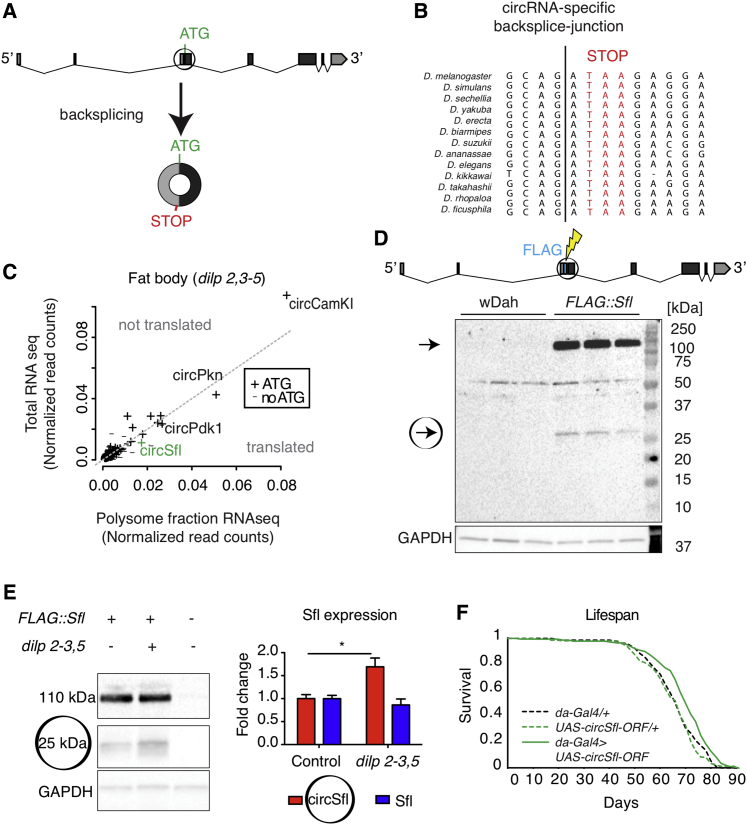
CircSfl Is Translated into a Protein that Is Upregulated in Insulin Mutant Flies(A) circSfl shares the ATG start codon with its linear RNA isoforms and encodes an in-frame stop codon directly after the backsplice junction.(B) Evolutionary conservation of the circSfl-specific stop codon among Drosophila species.(C) Polysome profiling of dilp2-3,5 mutant flies identified circSfl as a potentially translated circRNA. (+) indicates circRNAs that include the ATG start codon of their host genes.(D) CRISPR-mediated knockin of a FLAG tag to the N terminus of Sfl and circSfl (FLAG::Sfl mutants) resulted in two specific bands in a western blot analysis that were absent in wDah wild-type flies that do not carry a FLAG tag (heads, n = 3). The 110-kDa band corresponds to the Sfl full-length protein, and the 25-kDa protein corresponds to the protein size encoded by circSfl.(E) The 25-kDa protein, but not the 110 kDa Sfl protein variant, was increased in insulin mutant flies (∗p < 0.05, Student’s t test, n = 4, mean ± SEM).(F) Ubiquitous overexpression of the circSfl open reading frame (ORF) from a linear transcript extends the lifespan of female flies (overexpressor versus da-Gal4 driver or UAS control, ∗∗∗∗∗p < 0.0001; log-rank test, n = ~150).See also Figure S6 and Data S3.